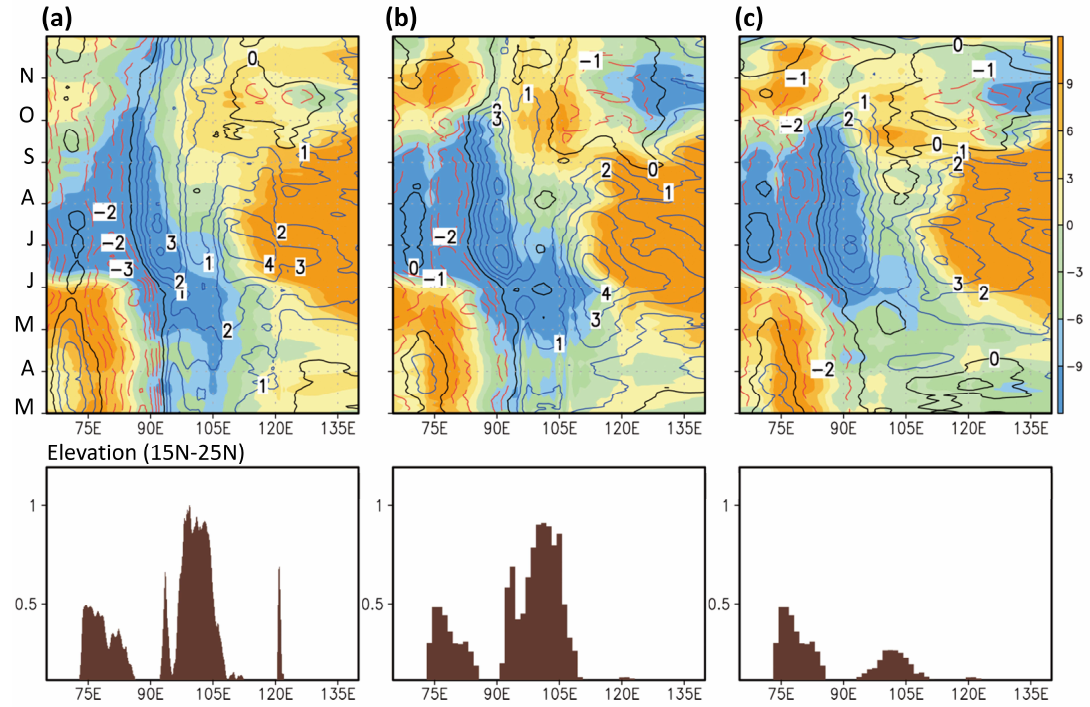
Figure 8. Longitude–time cross sections of eddy geopotential heights (gpm; shadings; average in 70° E–140° E has been subtracted) and meridional winds at 700 hPa (m s −1 ; contour lines) in 15° N–25° N: ( a ) CFSR data; ( b ) AA simulation; and ( c ) IP0 simulation. Black bars in the bottom panel denote the averaged elevation (km) in the region.